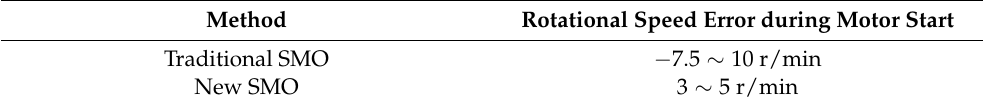
Table 4. Comparison of simulation results of rotational speed error.